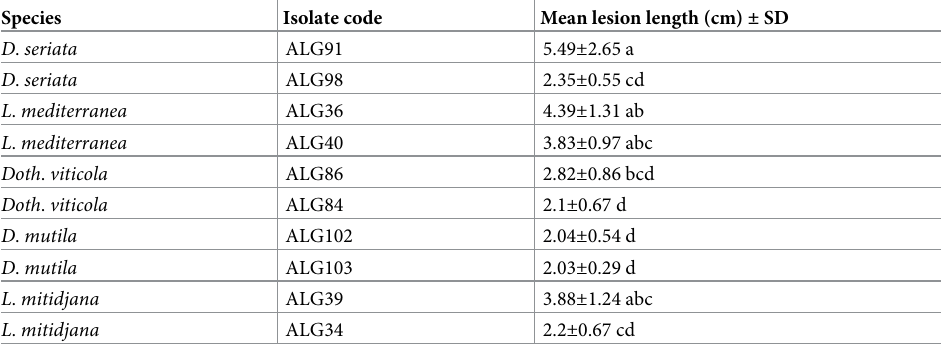
Table 3. Mean lesion lengths (cm) caused by Doth . viticola , D . mutila , D . seriata , L . mediterranea and L . mitidjana species implicated in citrus dieback in northern Algeria, 30 days after inoculation of detached green branches with mycelium-colonized agar